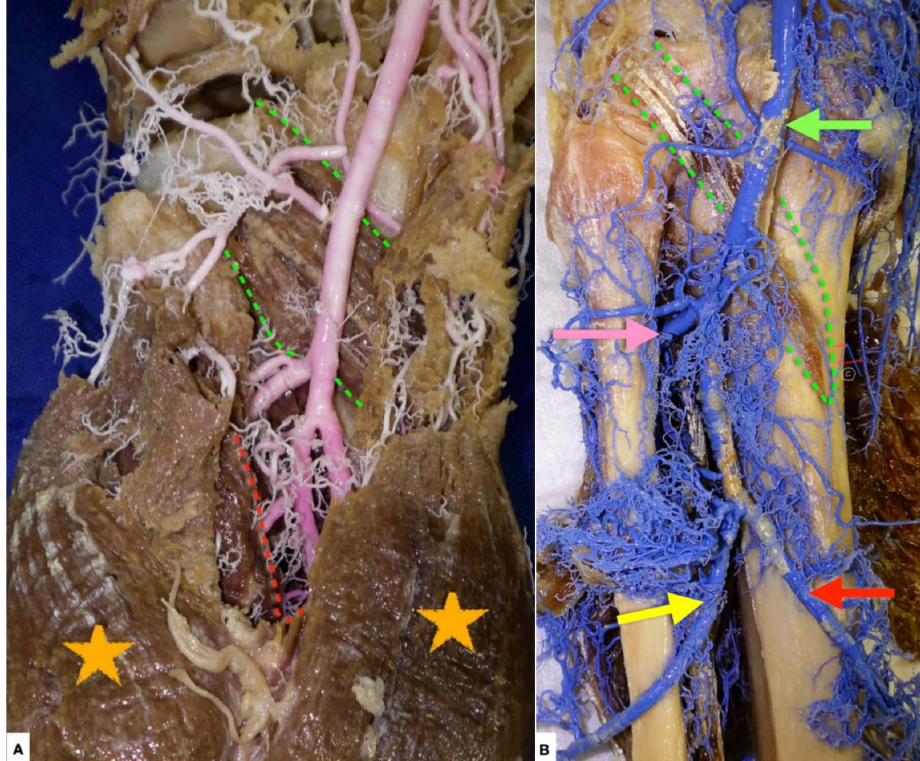
Figure 2. ( A ) Left knee, posterior view. The popliteal artery (pink vessel) is the continuation of the femoral artery, and it exits from Hunter canal and enters the popliteal fossa at the junction of the middle and lower third of the femur. Distally, the artery runs superficially to the popliteus muscle fascia (green dotted line) In the popliteal fossa, the artery is deep and medial to the popliteal vein and tibial nerve. Proximally, it is separated from the femoral bone by a thick pad of fat. There is firm anatomic fixation of the popliteal artery in the adductor hiatus tendineus proximally and the arcus tendineus musculi solei distally (red dotted line). Orange stars: medial and lateral head of gastrocnemius muscle. ( B ) Left knee, posterior view, all muscles and soft tissues chemically debrided. The popliteal artery (green arrow) ends at the lower border of the popliteus (green dotted line) by dividing into the anterior (pink arrow) and posterior tibial (red arrow) and peroneal (yellow arrow) arteries. The calculated incidence of popliteal artery injury is 5.67 per 10,000 cases of TKA, a percentage that rises in revision TKA cases [1]. Approximately 10% of patients with knee dislocations have popliteal artery injury